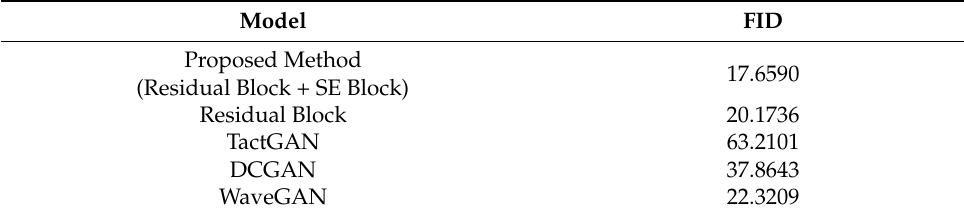
Table 5. Comparison of learning models by FID